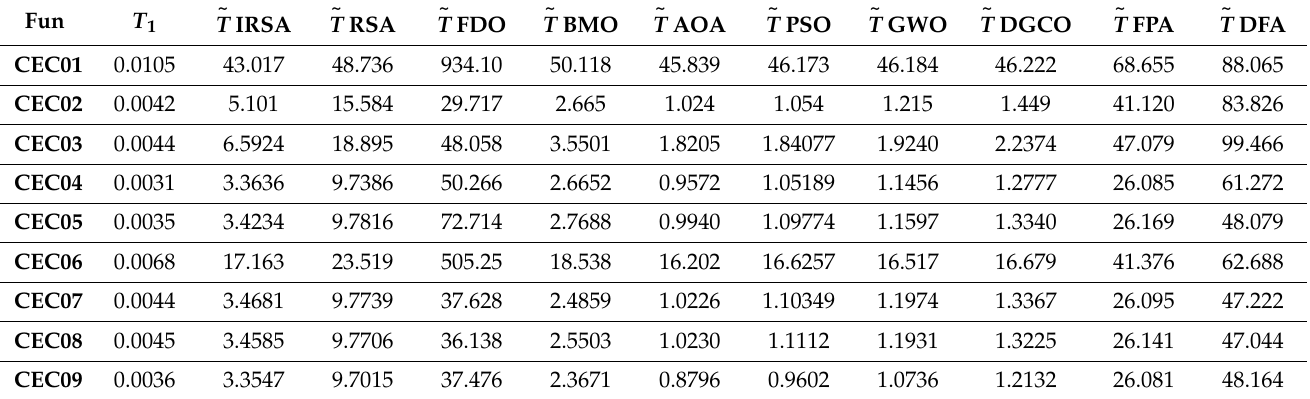
Table 5. T ( sec ) calculation for various metaheuristic